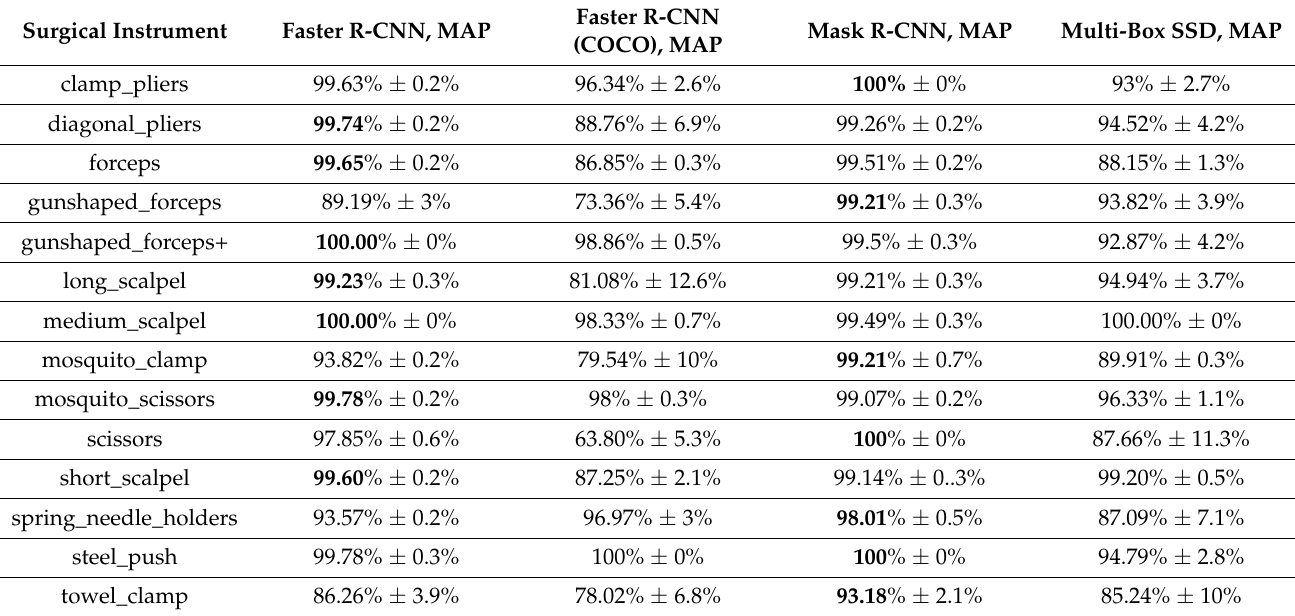
Table 2. Classification results of the networks trained used surgical instrument data with a 95% confidence interval. Surgical Instrument